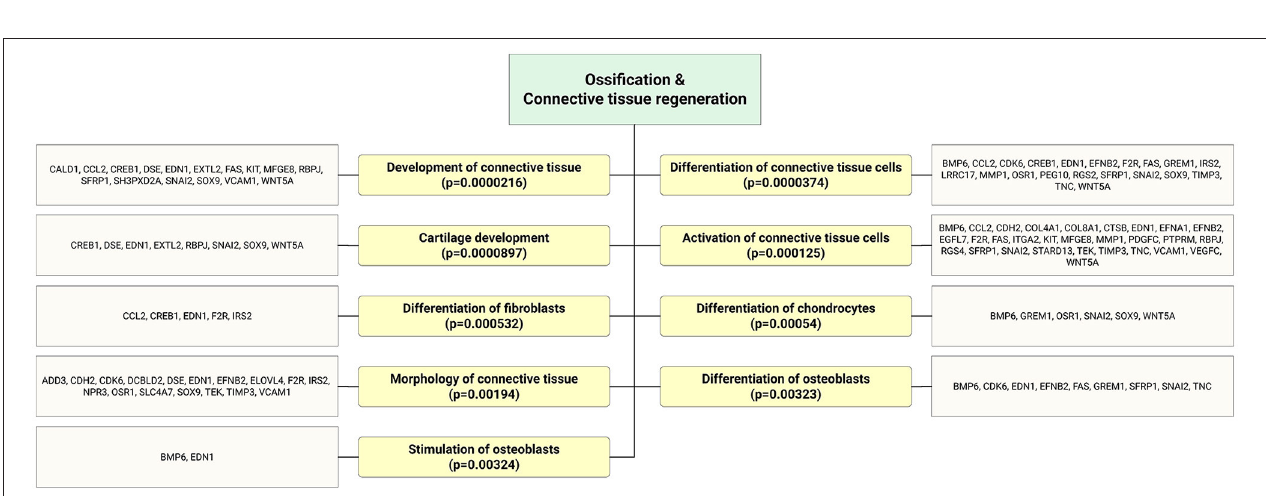
FIGURE 6 | Highly expressed ECFC-EC-derived miRs biological targets were predicted, and the most significantly enriched functional annotations were cell migration and cell cycle. This miR sequence data was generated from PMID: 28631889. MicroRNA target genes were predicted using IPA with information from TargetScan, miRecords, and TarBase databases.